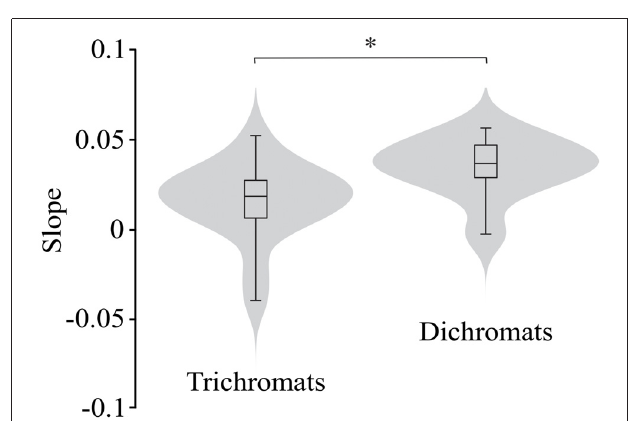
FIGURE 7 | Violin plots comparing the slopes estimated from the best individual linear fits to the ellipse area as a function of the luminance noise amplitude from trichromats and congenital dichromats. Dichromats had larger slopes than trichromats. Shaded gray areas are the kernel density plot that represents 95% of the data distribution, and the box plot comprises horizontal lines that represent third quartile (upper line), median (middle line), first quartile (lower line) and whiskers represents the maximum and minimum values. ∗ p <